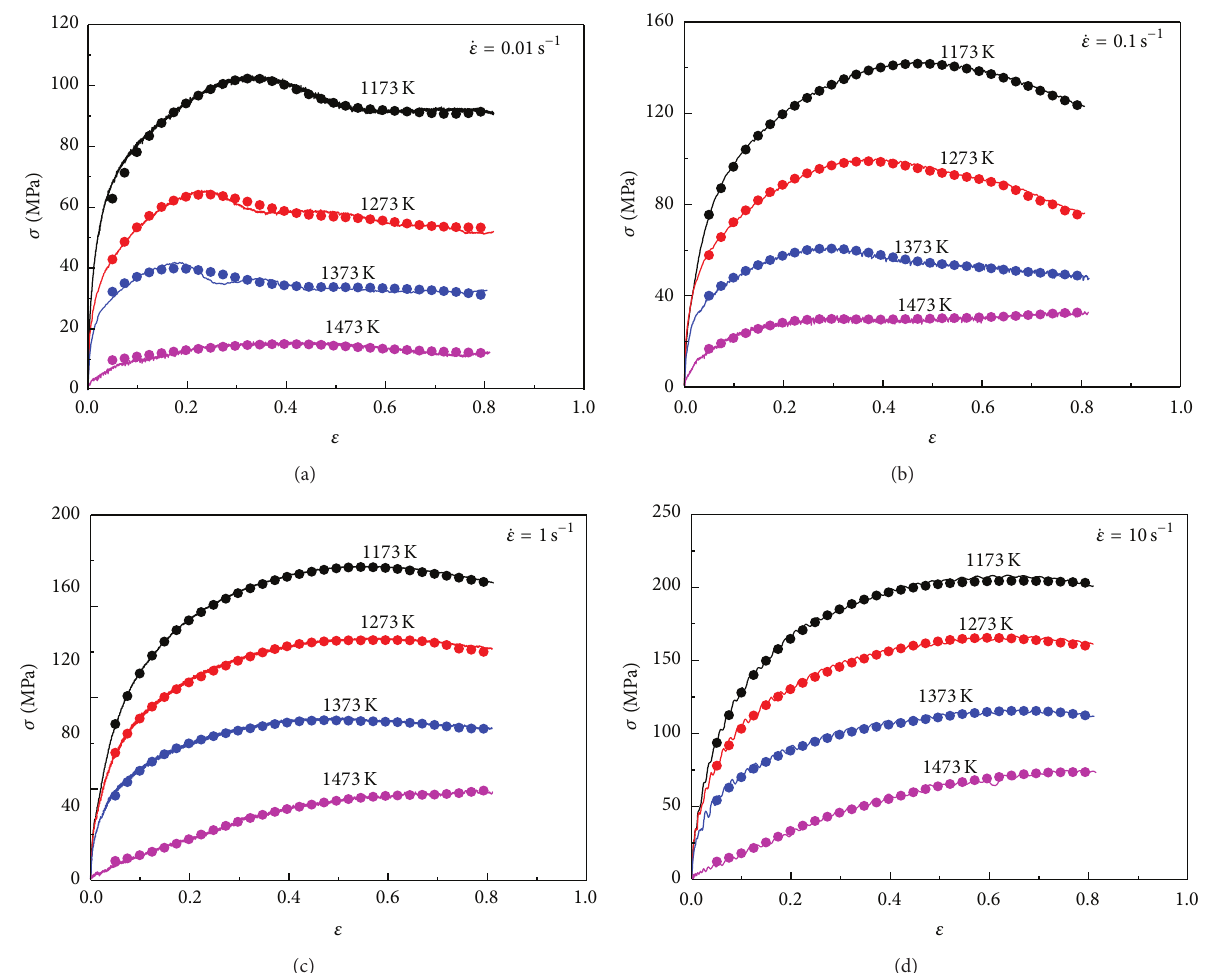
Figure 8: Comparison between the experimental and predicted flow stress by ANN model at different strain rates and temperatures (a) 0.01 s −1 , (b) 0.1 s −1 , (c) 1 s −1 , and (d) 10 s −1